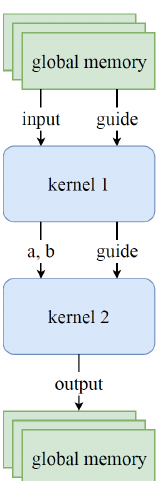
Figure 7. Kernel 1 computes the first three steps in the guided image filter algorithm, while kernel 2 computes the last two